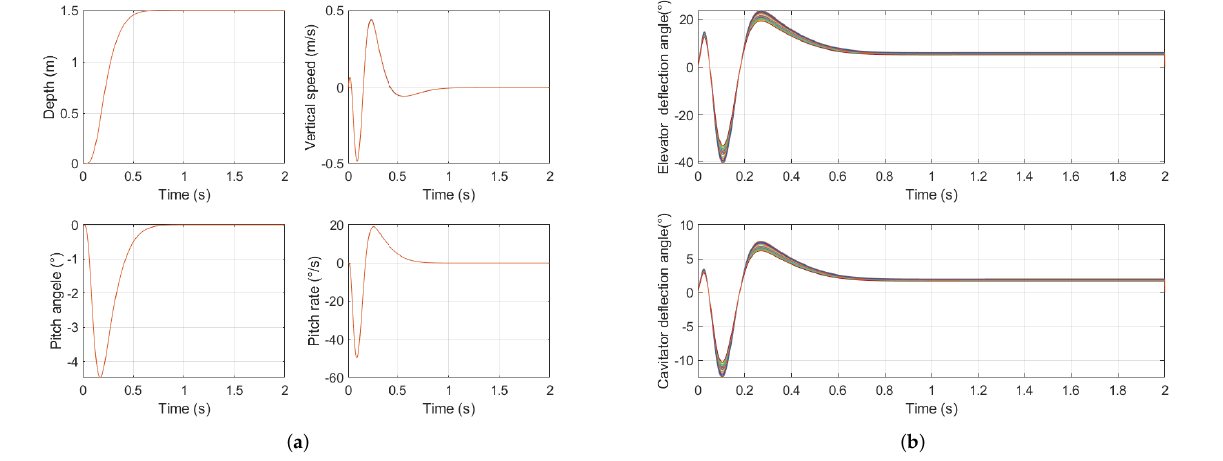
Figure 11. Monte Carlo simulation with perturbation of C x 0 : ( a ) Four states with perturbation of C x 0 ; ( b ) Actuator with perturbation of C x 0 .